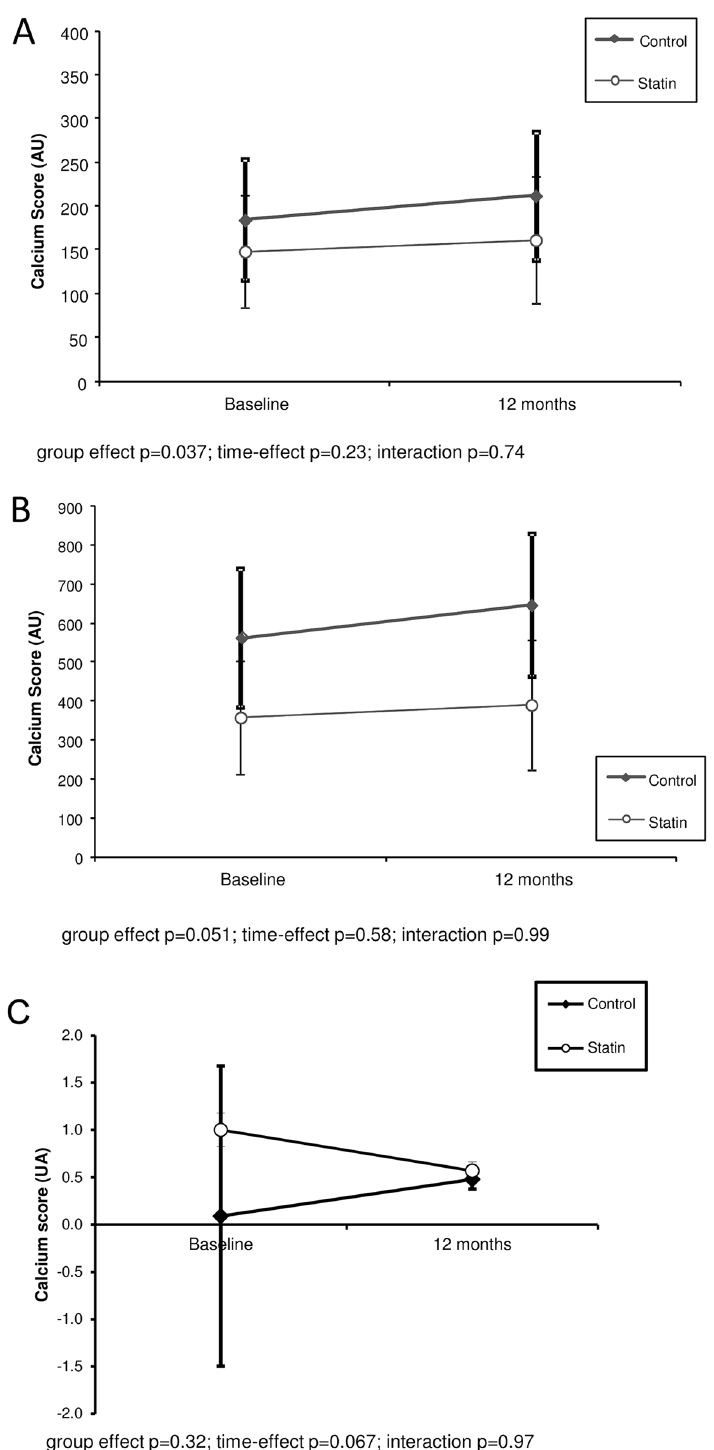
Fig 3. CAC progression in the groups (A — All patients; B — (cid:1) 10 AU [calcified patients]; C — < 10 AU [non calcified patients]).